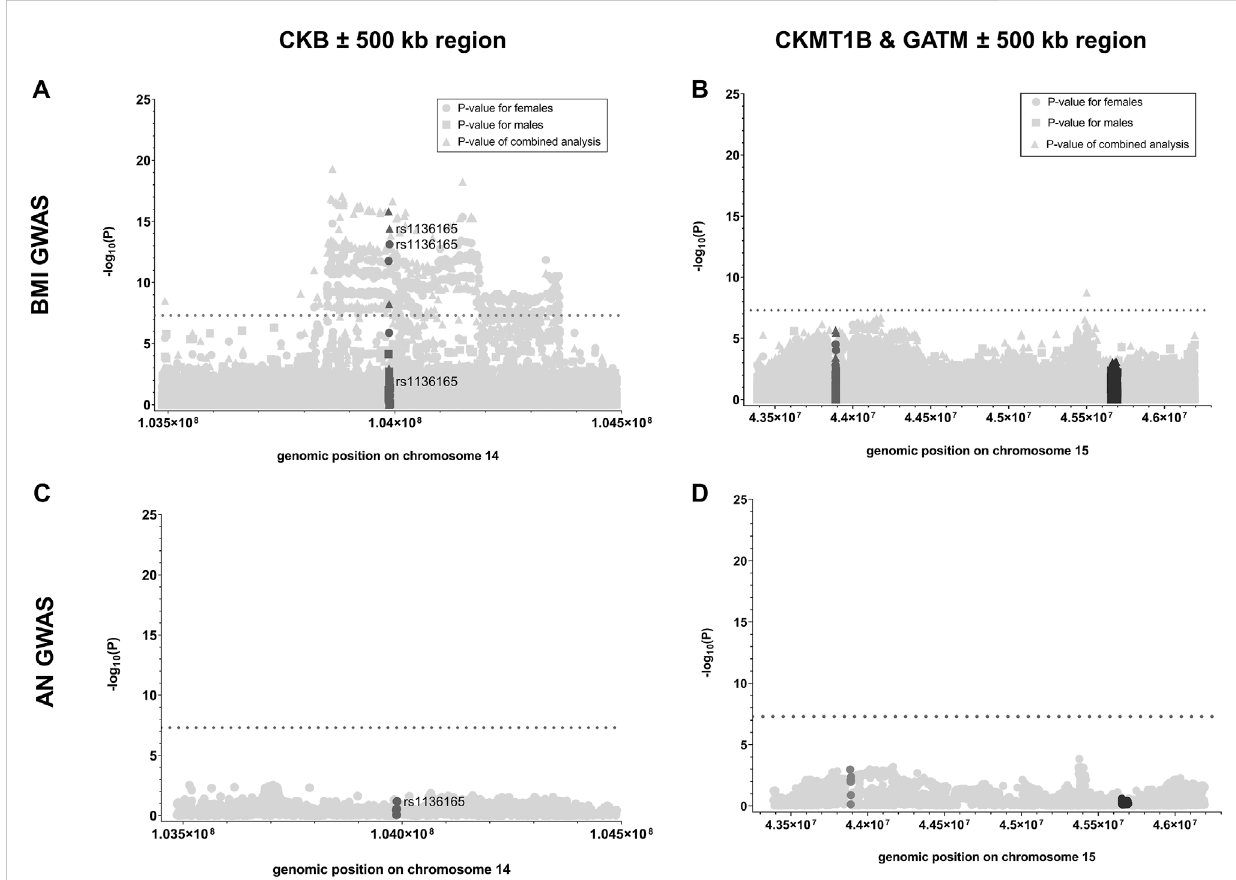
FIGURE 2 p -values of SNPs analyzed in GWAS for BMI or AN located within the genes of interest and their adjacent regions. Here, the negative logarithmic p -values extracted from the sex-strati fi ed BMI GWAS [Pulit et al., 2019; (A, B) ] and the GWAS for AN (Watson et al., 2019; (C, D) are plotted against the genomic positions of the SNPs located within CKB (A, C) ; dark gray), CKMT1B [ (B, D) ; dark gray] and GATM [ (B, D) ; black] as well as their 500 kb adjacent regions (light gray; GRCh37; see Table 1; Supplementary Table S2). For the data regarding the sex-strati fi ed BMI GWAS, the negative logarithmic p -values are presented for the female (dot), male (square), and combined (triangle) analyses. The threshold for genome-wide signi fi cance is indicated by the dotted lines (-log 10 (p) >